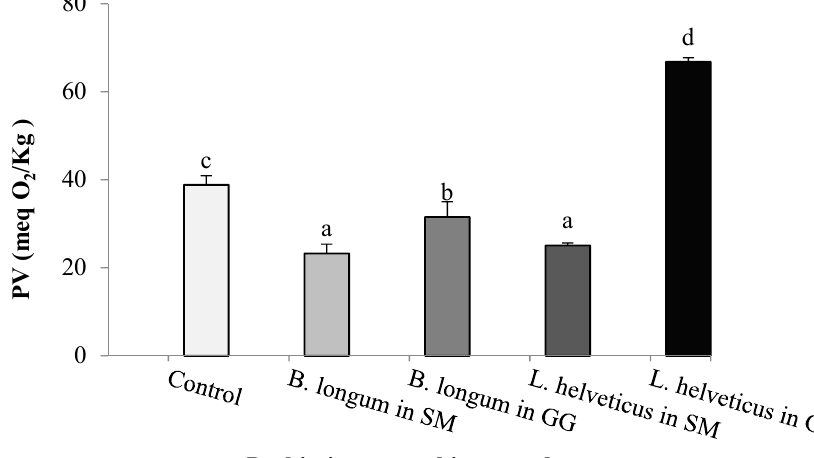
Figure 2. Peroxide value (PV) of the extracted oil from different probiotic potato chips samples. Potato chips containing probiotic Bifidobacterium longum and Lactobacillus helveticus (lyophilized in skim milk or gelatin/glycerol medium) or without LAB (control), were analyzed after storage at 30 °C for 4 months. a–d Di ff erent letters in the columns di ff er significantly ( p <